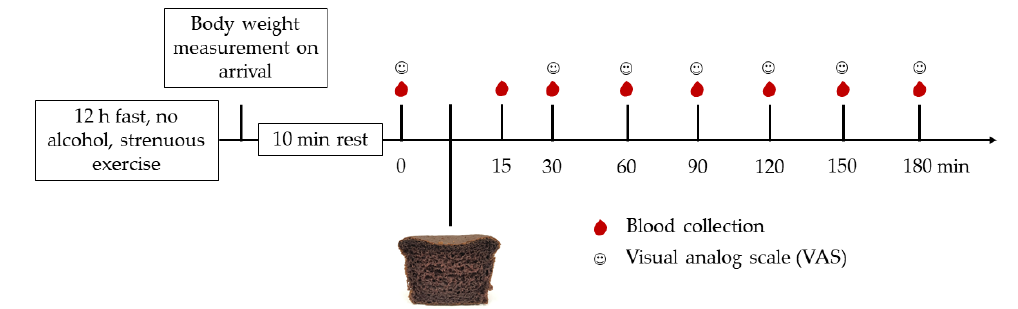
Figure 2. Study visit protocol.